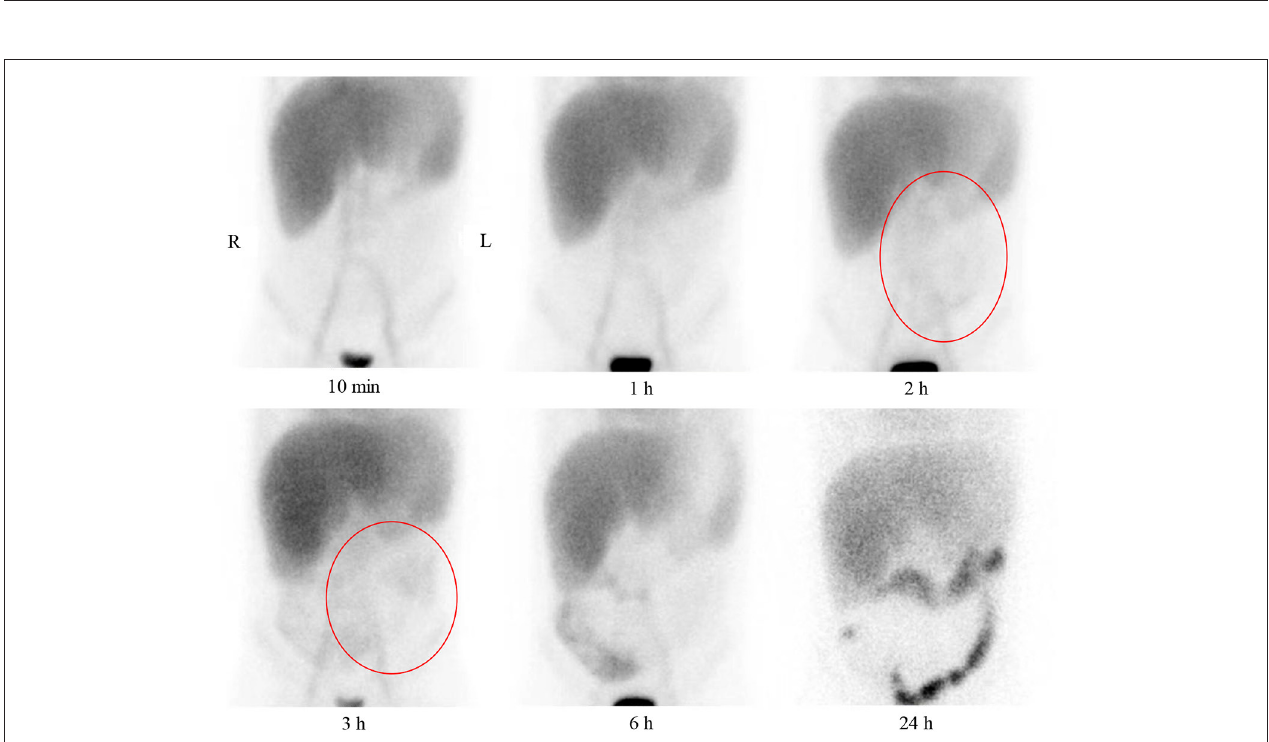
FIGURE 3 | Anterior plane abdominal scintigraphy at 10min and 1, 2, 3, 6, and 24h after intravenous administration of technetium-99m-labeled human serum albumin. Tracer accumulation in large vessels, heart blood pool, liver, and kidney is present at 10min and 1h. Tracer accumulation in the abdomen is not present at 10min and 1h. Tracer accumulation in the lower abdomen is vaguely observed at 2 and 3h (red circles). A large amount of tracer accumulation is present in the right lower abdomen at 6h, and the radionuclide shows the bowel. Clear colonic tracer accumulation is present at 24h.